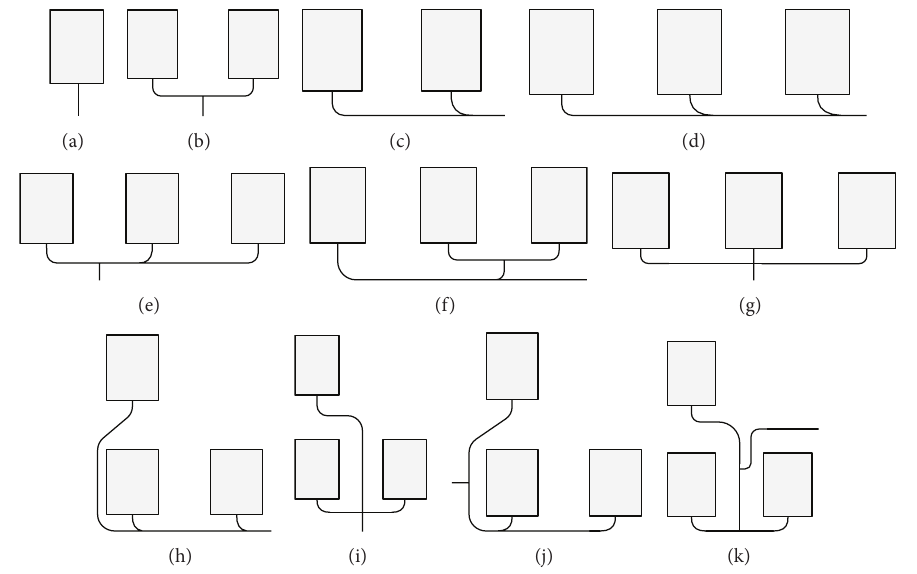
Figure 2: Configuration of the basic array element modules (a) 𝑀 1 (b) 𝑀 2−1 (c) 𝑀 2−2 (d) 𝑀 3−1 (e) 𝑀 3−2 (f) 𝑀 3−3 (g) 𝑀 3−4 (h) 𝑀 3−5 (i) 𝑀 3−6 (j) 𝑀 3−7 (k) 𝑀 3−8